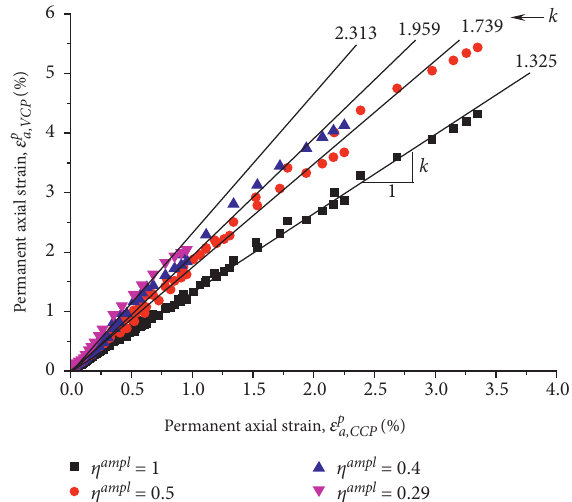
Figure 13: Relationships between permanent axial strains in VCP and CCP tests.